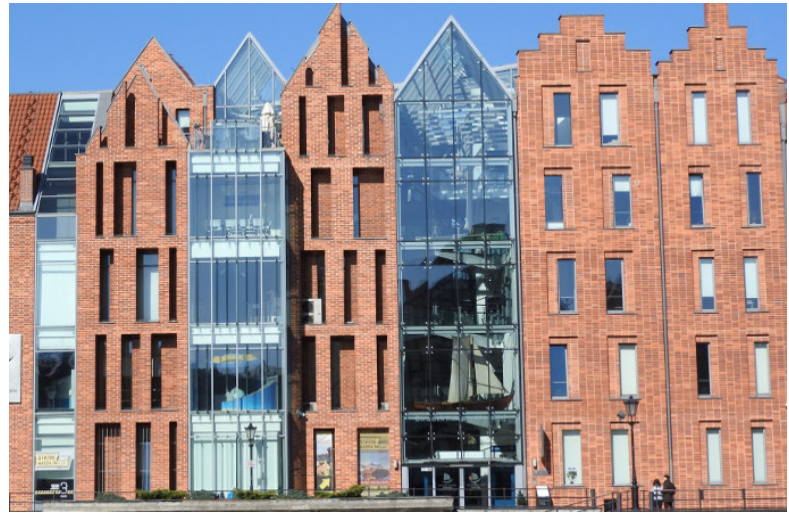
Figure 16. Maritime Culture Centre in Gda ń sk; designed by Miros ł aw Fr ą szczak. Source: InfoG- da ń sk [57].